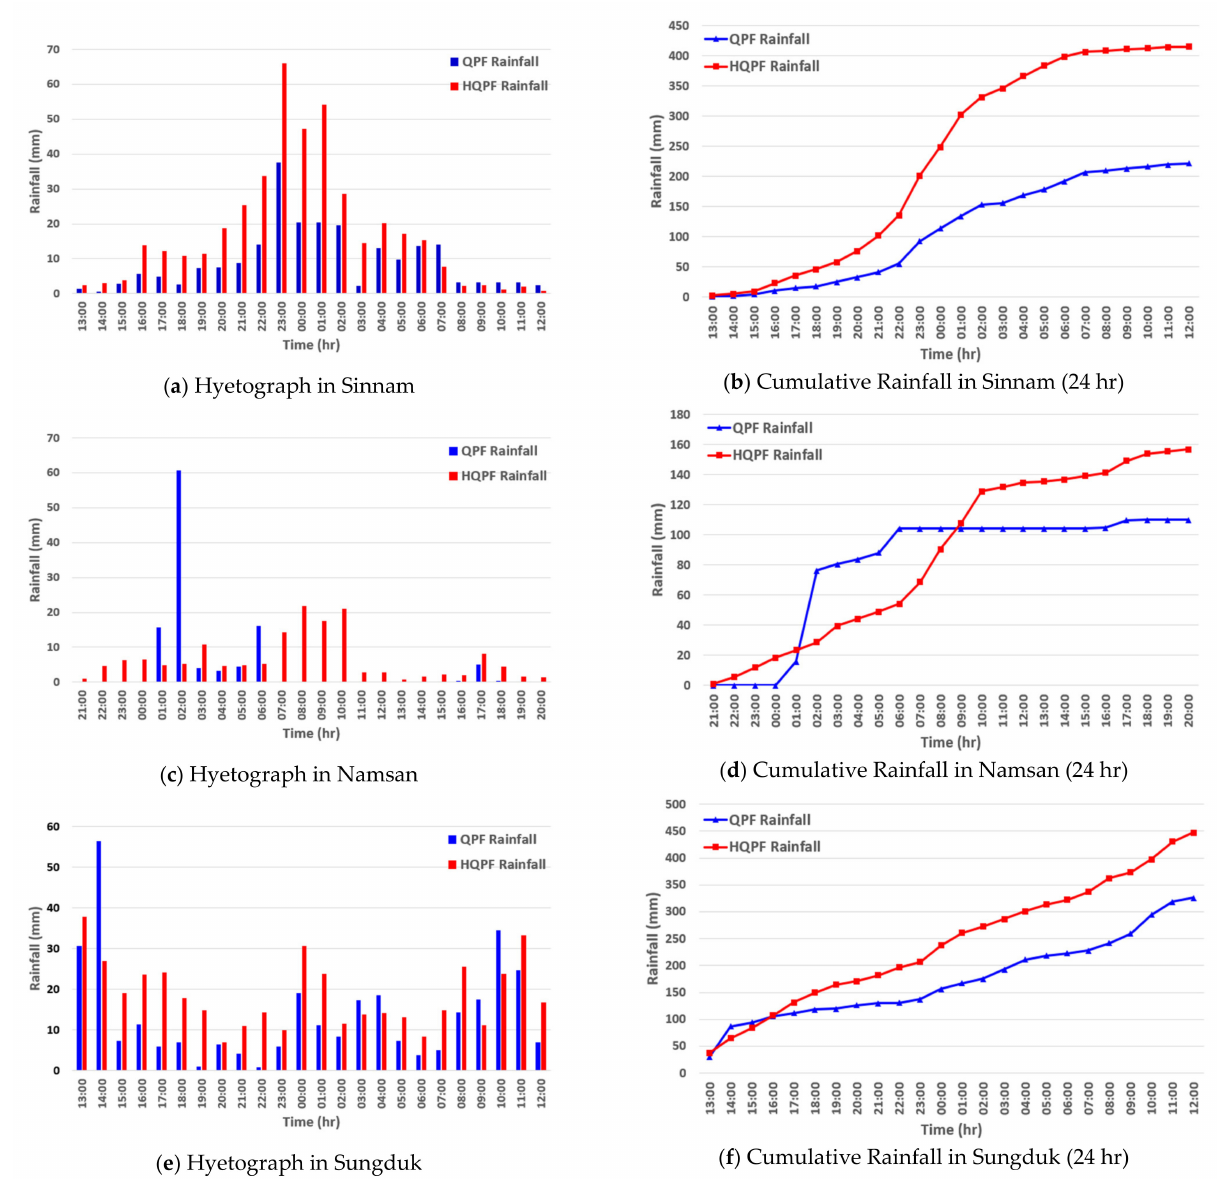
Figure 10. Hyetograph of the Study Area. ( a ) Hyetograph of Sinnam Village, ( b ) 24-h cumulative rainfall of Sinnam Village, ( c ) Hyetograph of Namsan Village, ( d ) 24-h cumulative rainfall of Namsan Village, ( e ) Hyetograph of Sungdeok Village, ( f ) 24-h cumulative rainfall of Sungdeok Village. In the bar graphs of ( a , c , e ), blue is QPF Rainfall and red is HQPF Rainfall. In the solid line graphs of ( b , d , f ), blue is QPF and red is It means HQPF, and the dots marked for each hour mean the accumulated rainfall for that